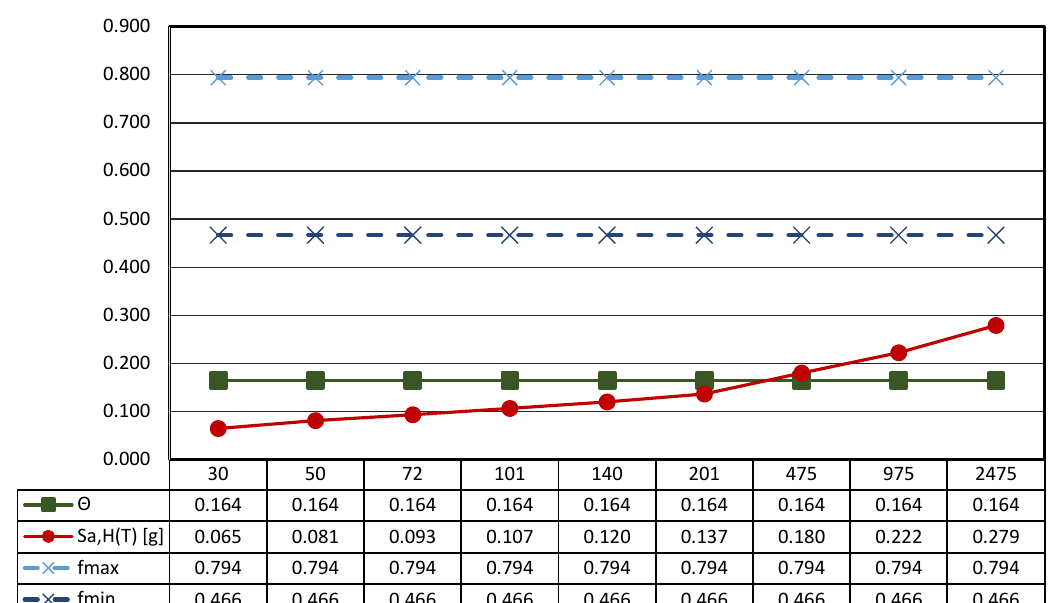
Table 4. Summary of the main geometric features of the asset for seismic rigid block analyses.